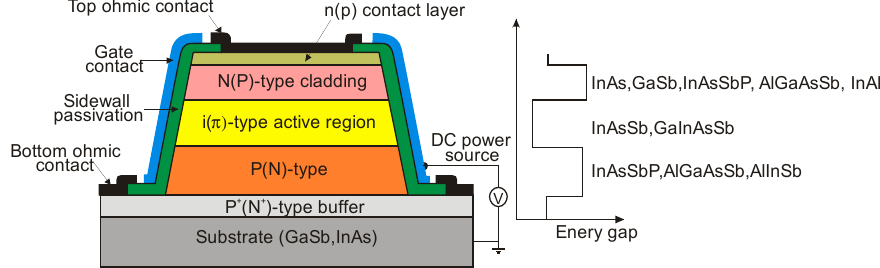
Figure 34. N-i-P double heterostructure photodiode schematic cross-section. Different combinations of III–V materials for active and cladding layers are also shown (after [91]).